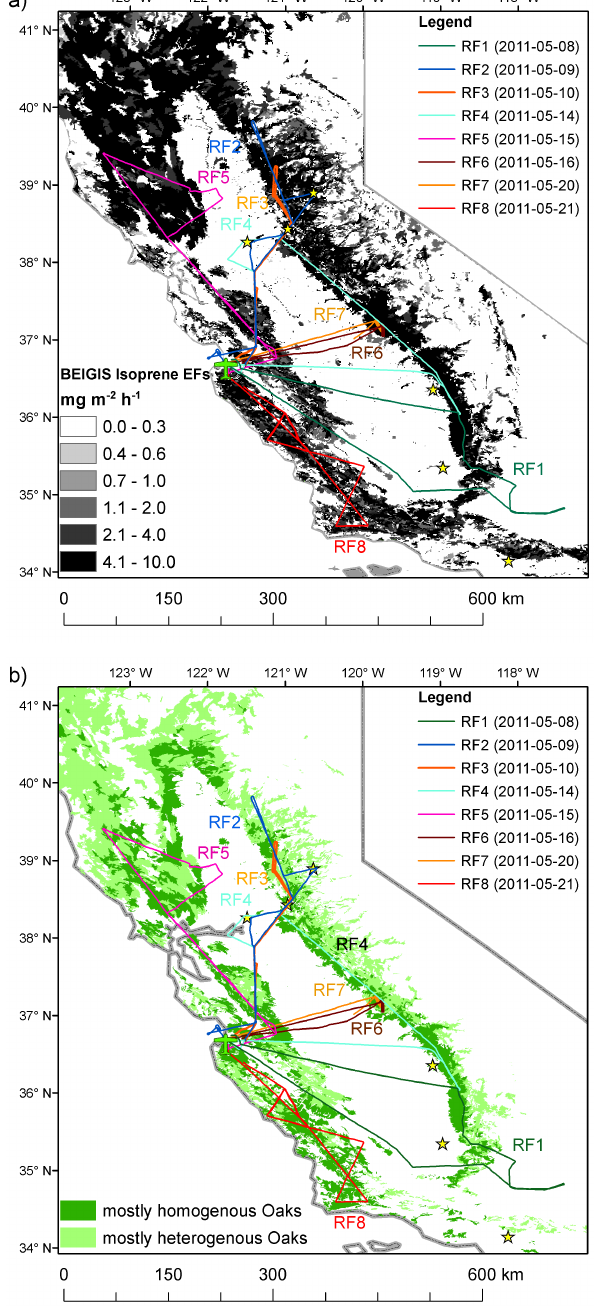
Figure 1. Tracks flown during CABERNET overlaid over (a) BEIGIS-isoprene-emission-factor (EF) land cover; and (b) oak- woodland ecosystems differing in oak species spatial homogeneity (according to the GAP